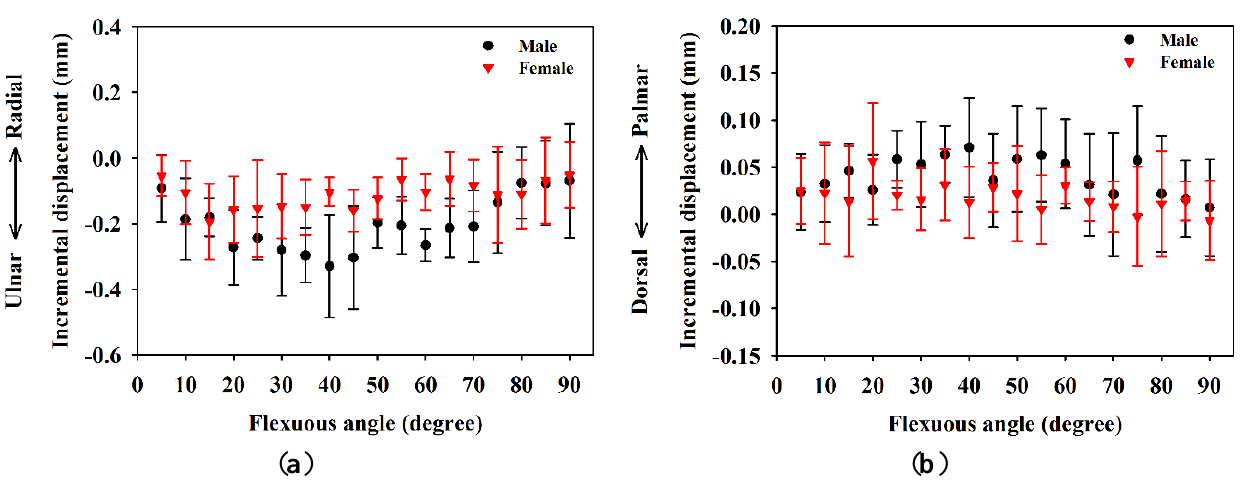
Figure 5. Incremental displacements of the MN in the ( a ) ulnar-radial direction